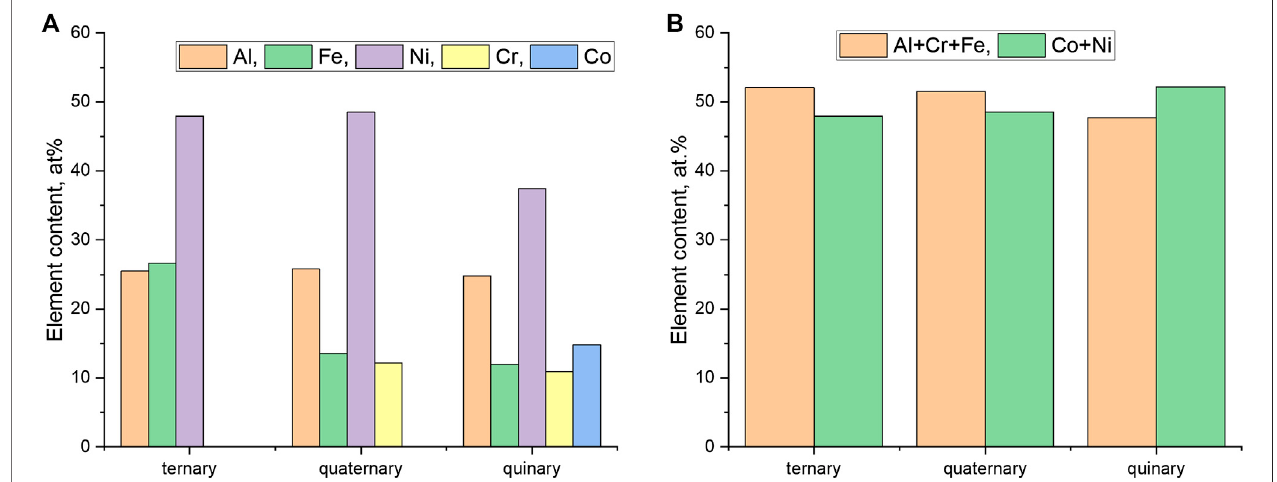
FIGURE4| GraphicalvisualizationofthecompositionaldataoftheBCC-B2phaseforallthreealloysgivenin Table3( A ) andgroupingoftheelementsaccordingto two separate crystallographic sites in the BCC-B2 phase (B) .